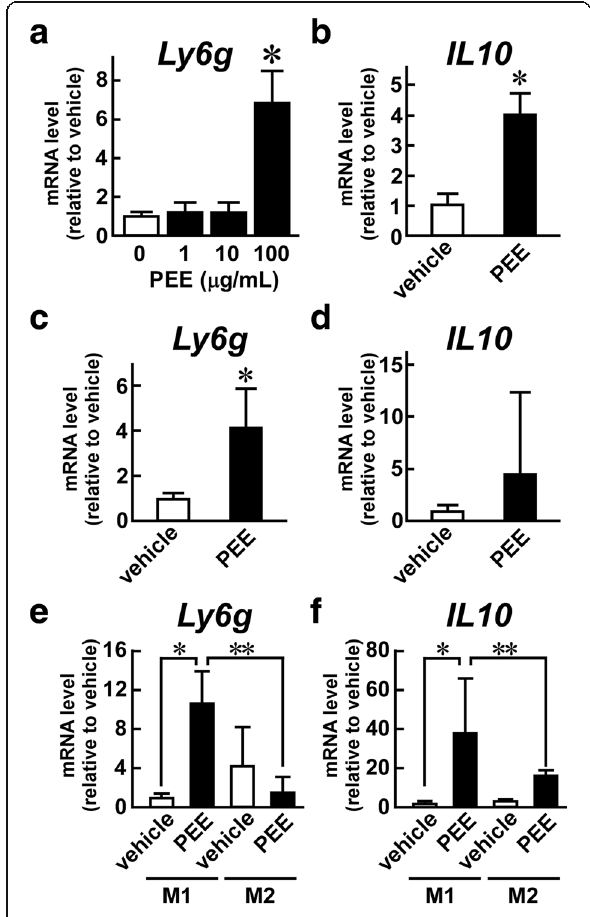
Fig. 5 PEE induces MDSC markers in cultured macrophages. a , b Thioglycolate-elicited peritoneal macrophages, ( c , d ) J774.1 cells, and (E, F) GM-CSF-elicited M1 and M-CSF-elicited M2 macrophages were stimulated with PEE ( a ; 1, 10, or 100 μ g/mL: b - f ; 100 μ g/mL) for 24 h. Subsequent qRT-PCR for ( a, c, e ) Ly6g and ( b , d , f ) Il10 was performed. Values were normalized to ( a-d ) Hprt1 mRNA or ( e , f ) 18 s rRNA levels, and represented as the means ± SD of ( a , b , e , f ) 4 or ( c , d ) 3 samples. * P < 0.05 vs. vehicle-treated mice; ** P < 0.05